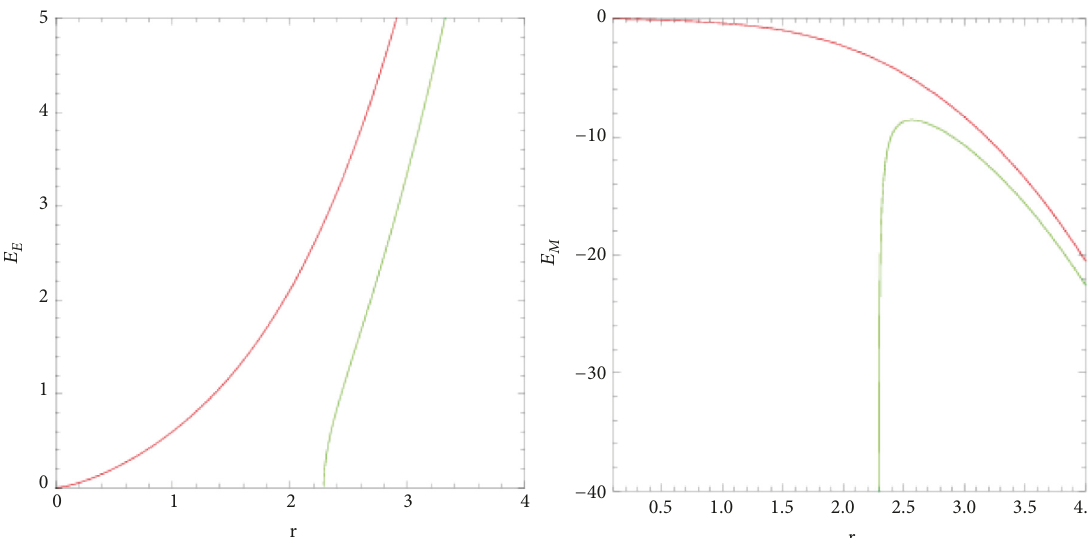
Figure 1: Evolution of the Einstein energy 𝐸 𝐸 (left) and of the Møller energy 𝐸 𝑀 (right) with respect to the 𝑟 coordinate for the massive and charged black hole. In both cases we have chosen 𝑀 = 1 and 𝑞 = 1 , while the red line and the green line correspond to Λ = 1 and Λ = −1 , respectively.